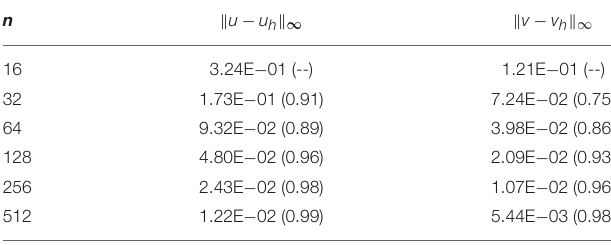
TABLE 2 | Convergence of the finite difference method for the manufactured test problem with convergence rates in